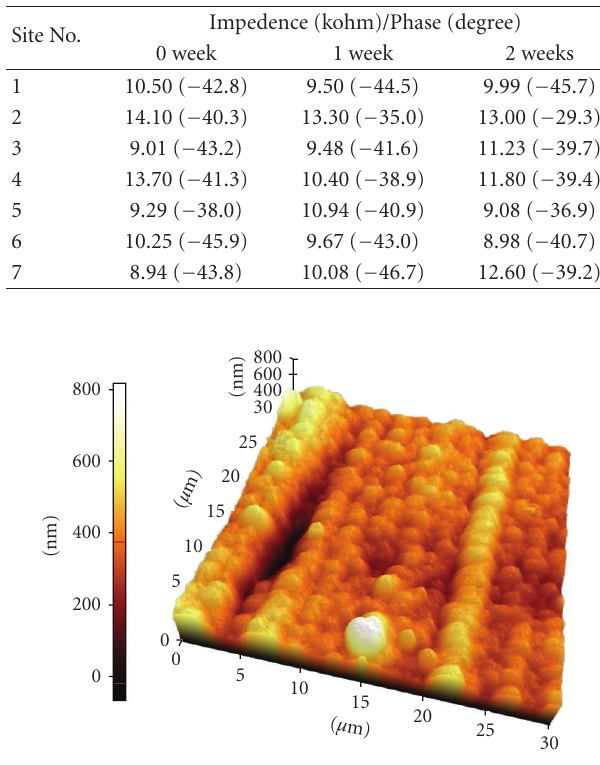
Figure 7: An AFM image of gold/polyimide electrode surface. The average surface roughness was